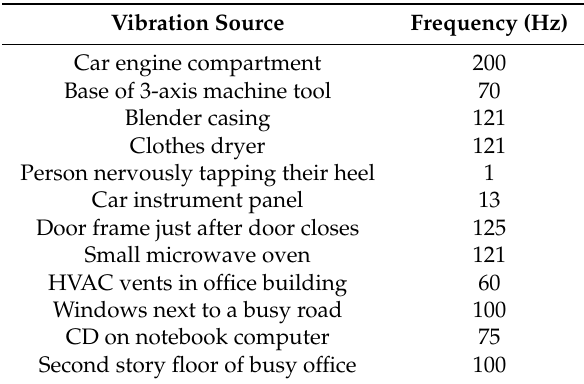
Table 2. Parameters of each